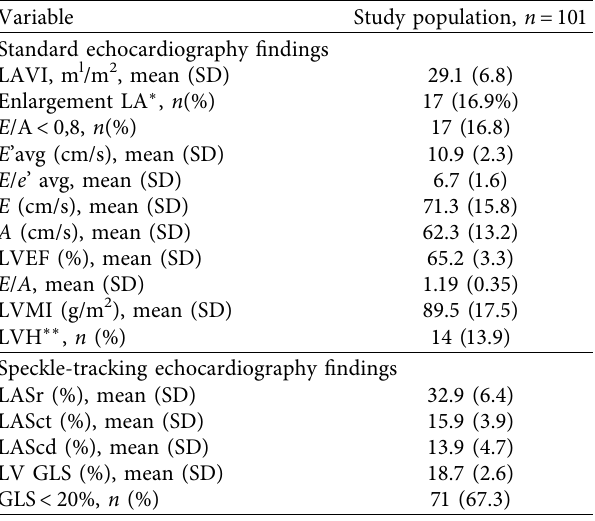
Table 2: Echocardiography data for the study